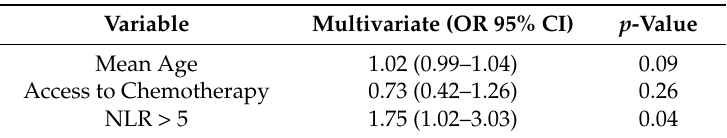
Table 3. Multivariate analysis of risk factors for OS in 81 pancreatic cancer patients with metastatic disease at the time of diagnosis.